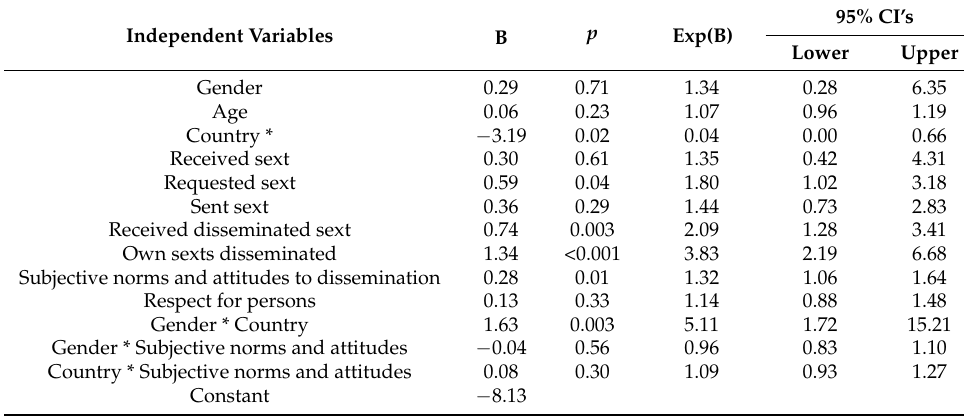
Table 5. Regression results for overall